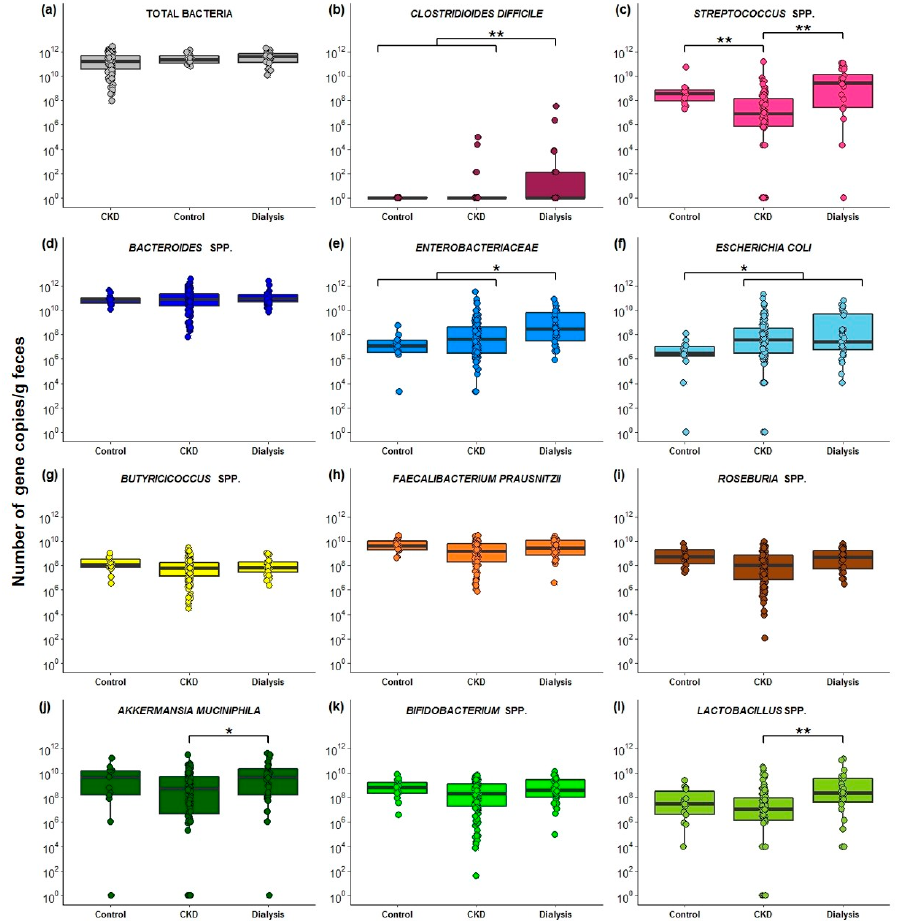
Figure 2. Bacterial gene copies per gram feces for the control, CKD and dialysis group: ( a ) Total bacterial 16S rRNA; ( b ) Clostridioides difficile ; ( c ) Streptococcus spp.; ( d ) Bacteroides spp.; ( e ) Enterobacteriaceae ; ( f ) Escherichia coli ; ( g ) Butyricicoccus spp.; ( h ) Faecalibacterium prausnitzii ; ( i ) Roseburia spp.; ( j ) Akkermansia muciniphila ; ( k ) Bifidobacterium spp.; ( l ) Lactobacillus spp. *: p ≤ 0.05; ** p ≤ 0.001.